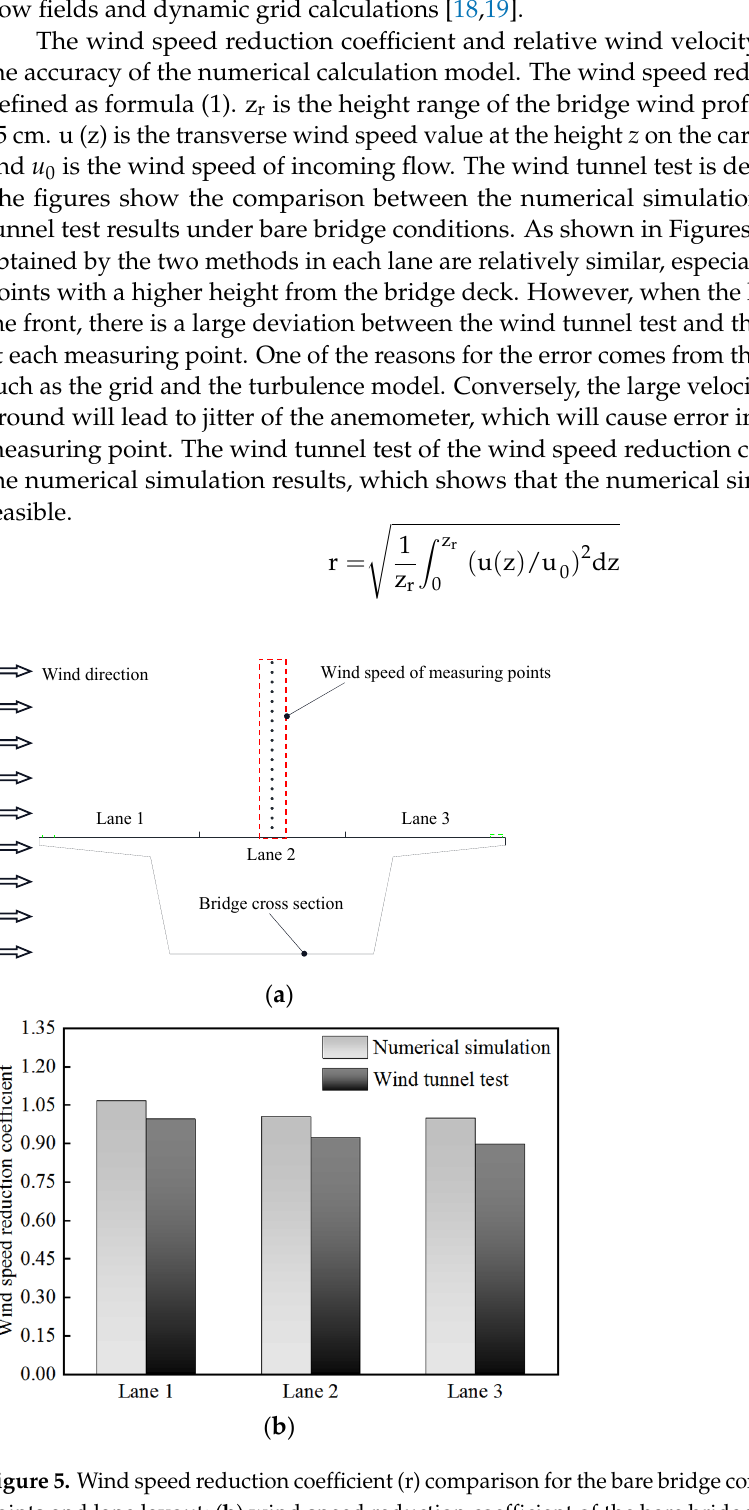
Figure 4. The mesh rendering of a vehicle on the bridge (( a ) Front view of the domain; ( b ) side view of the domain).